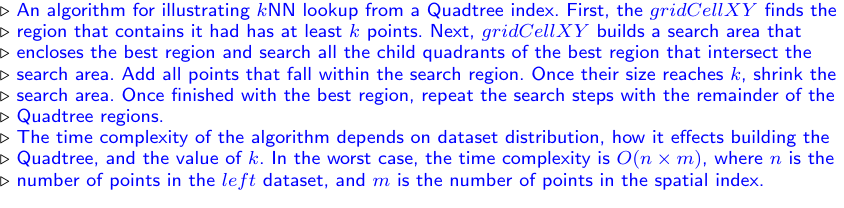
Algorithm 3 k NN Lookup Within Spatial Index